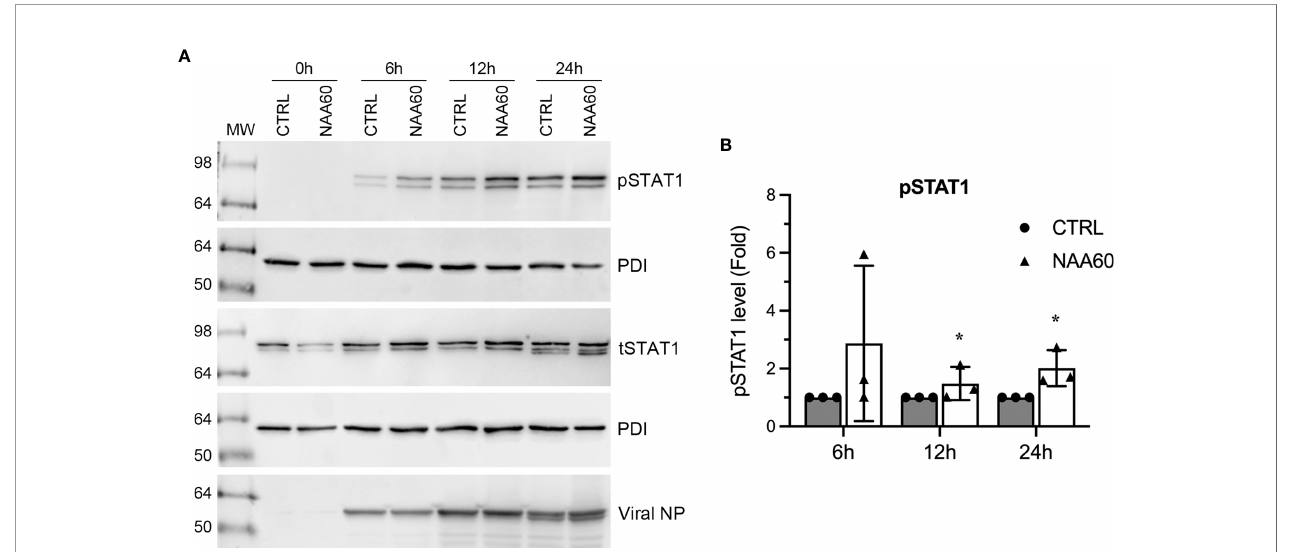
FIGURE 4 | The depletion of NAA60 increases IAV-induced pSTAT1 levels. A549 cells were transfected with 10 nM of CTRL or NAA60 siRNA for 72 h. One set of the cells was processed to con fi rm the depletion of NAA60 by RT-qPCR as in Figure 1A (not shown). The other set of the cells was infected with PR8 at an MOI of 1.0 for 0 h, 6 h, 12 h, or 24 h, and the cells were processed to detect the pSTAT1 (87 kDa), tSTAT1 (87 kDa), viral NP (56 kDa) and PDI polypeptide levels on separate blots by western blotting (A) . (B) The intensity of pSTAT1, tSTAT1 and corresponding PDI bands at 6 h, 12 h, and 24 h timepoints was quanti fi ed. First, the amount of pSTAT1 and tSTAT1 was normalized by the PDI amount at corresponding timepoints. Second, the amount of PDI-normalized pSTAT1 was normalized by the PDI-normalized tSTAT1 amount at each corresponding timepoint. Finally, the double-normalized values of pSTAT1 in CTRL siRNA transfected cells at indicated timepoint was considered 1-fold to determine its amount in NAA60 siRNA transfected cells at the corresponding timepoint. Error bars represent means ± standard deviation of at least three biological replicates; *P ≤ 0.05. MW, molecular weight; Grey bar, CTRL; White bar, NAA60.